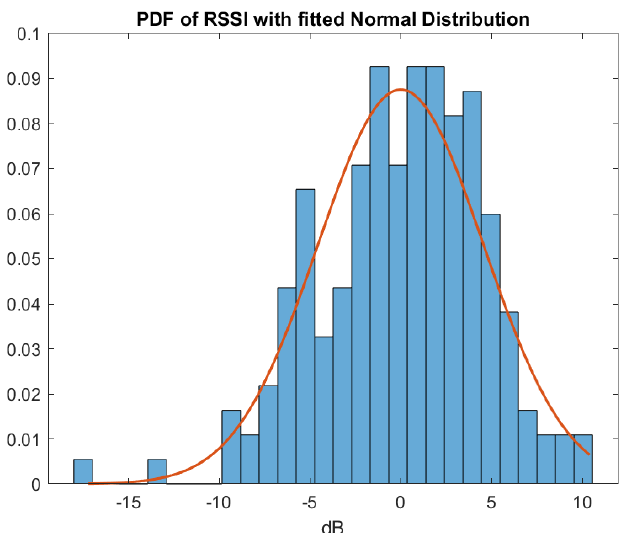
Figure 5. Histogram of RSSI variation from mean. (Observations are blue. Fitted Normal Curve is